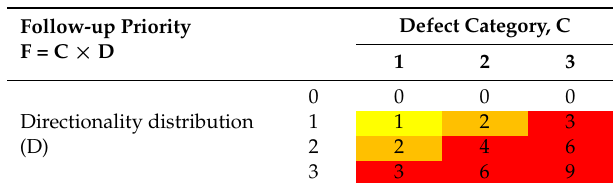
Table 3. Defect classification follow-up priority, F, scheme defined as the product of the defect category, C, and directionality distribution, D. If F = 0, then a classification is assigned for the weld feature; if F = 1, then a low priority is assigned for follow-up (yellow-shaded cell); if F = 2, then a medium follow-up priority is required (orange-shaded cell); if F ≥ 3, then a high follow-up priority is required for signals from defects (red-shaded cell)